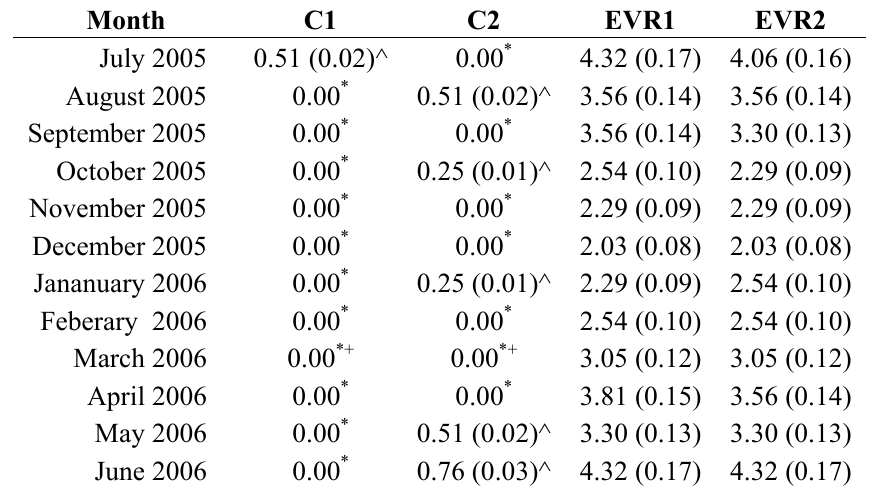
Table 1. ET monthly average comparison of the Chambers (mm/day (in./day)) [10].